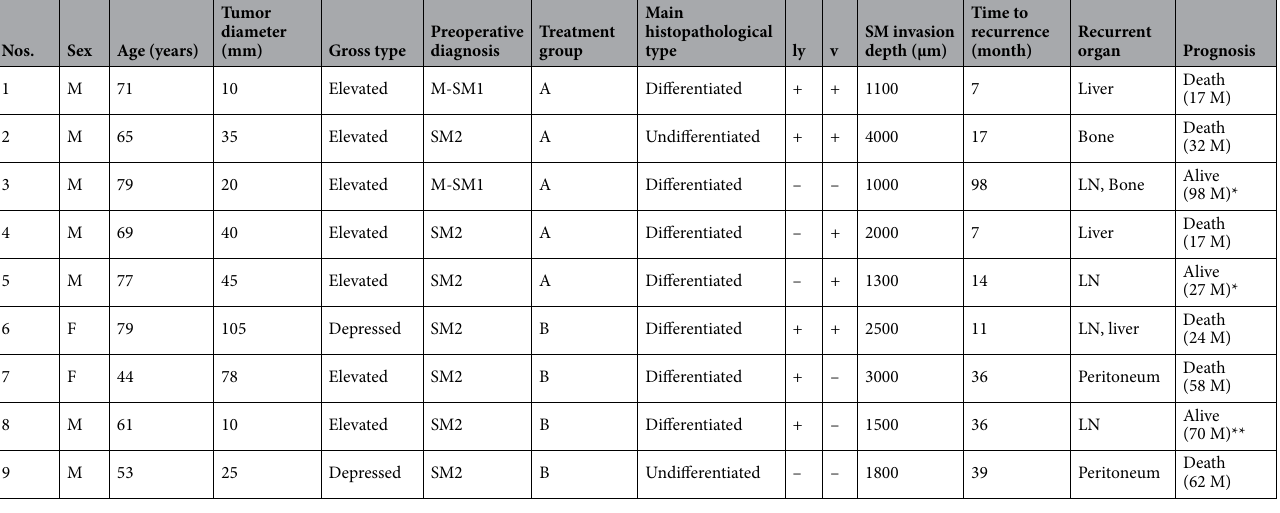
Table 4. Clinicopathological characteristics of 9 patients with recurrence after treatment for T1b2 gastric cancer. M: male, F: Female, SM1: submucosal cancer with the depth of submucosal invasion < 500 µm, SM2: submucosal cancer with the depth of submucosal invasion ≥ 500 µm. Group A: ESD + additional surgery, Group B: surgery, LN: lymph nodes, Death: Death of gastric cancer. *Best Supportive Care **chemotherapy by TS-1.